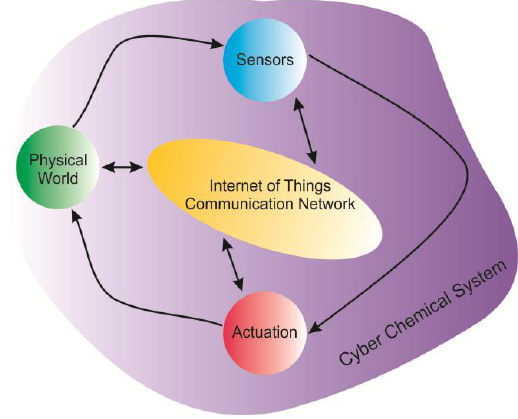
Figure 1. The framework of the proposed CCS.